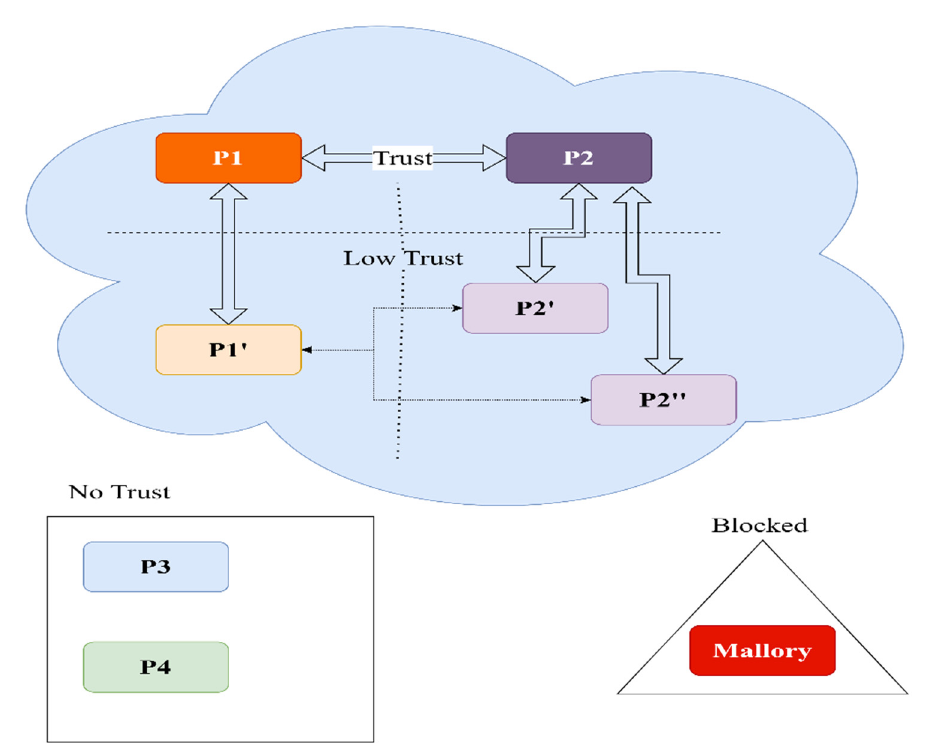
Figure 10. Trust